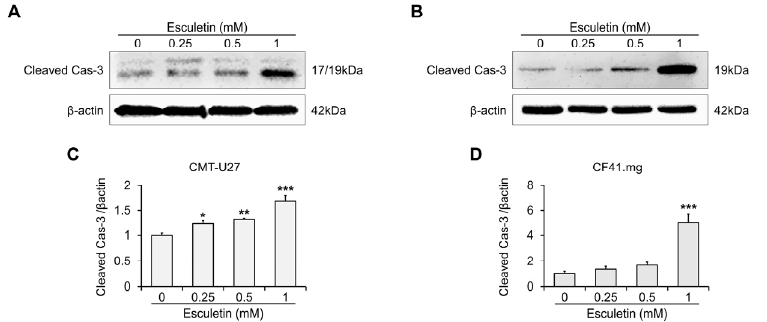
Figure 4. Esculetin induces apoptosis by activation of caspase 3 in CMT cells. ( A – D ) Images and quan- tification of the protein expression of cleaved cas-3 in CMT-U27 ( A , C ) and CF41.mg ( B , D ) cells after esculetin treatment. Values are mean ± SD. * p < 0.05, ** p < 0.01, *** p < 0.001 versus untreated cells by one-way ANOVA followed by Bonferroni post-test.